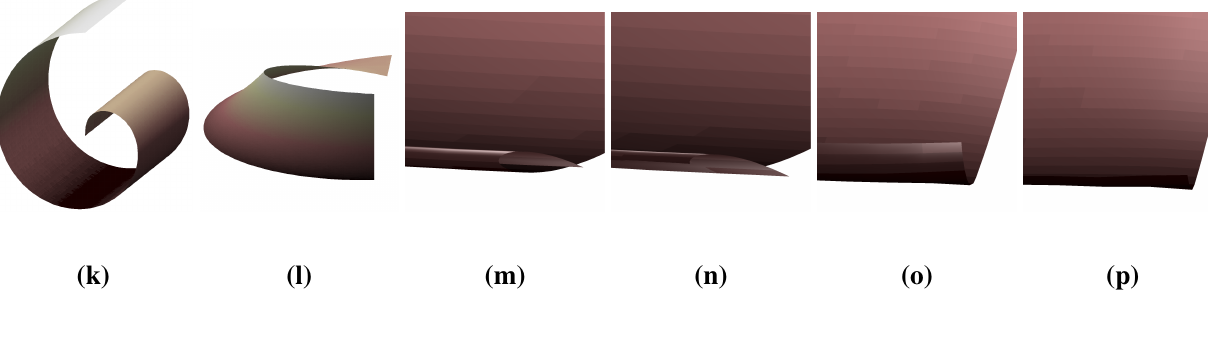
Figure 8. Occurrence of surface self-intersection using linear interpolation and our proposed morphing algorithm. The plot shows the occurrence of surface self-intersection in morphing the spiral-generated surface to the part of the Mobius strip (see Figure 8a,b). Self-intersection occurs during the 29th–35th frames. Note also that no self-intersections appears when we apply our proposed morphing